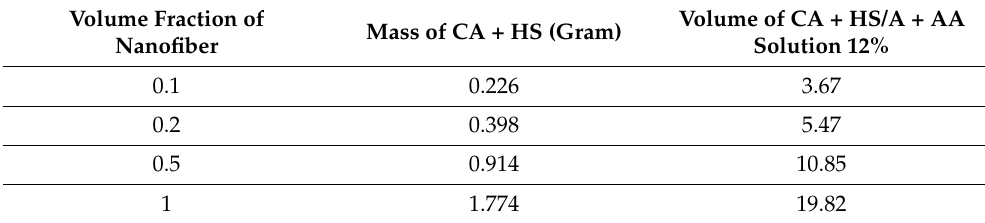
Table 5. Volume fraction for different concentrations of CA + HS/acetone + acetic